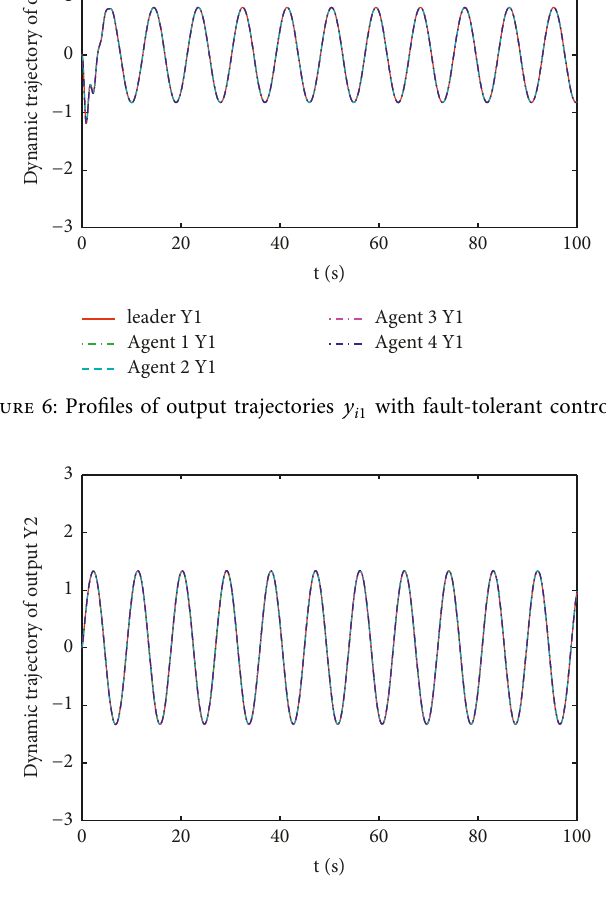
i 2 with fault-tolerant